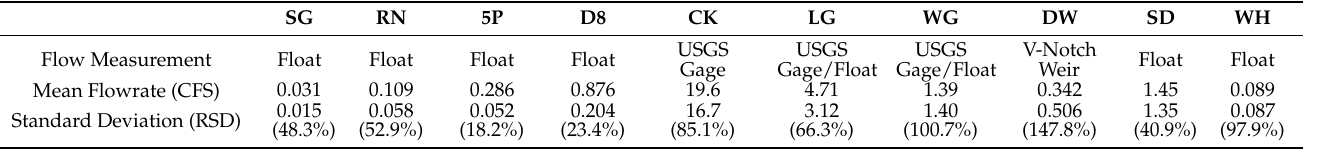
Table 4. Mean flowrates and standard deviation for each site along with measurement